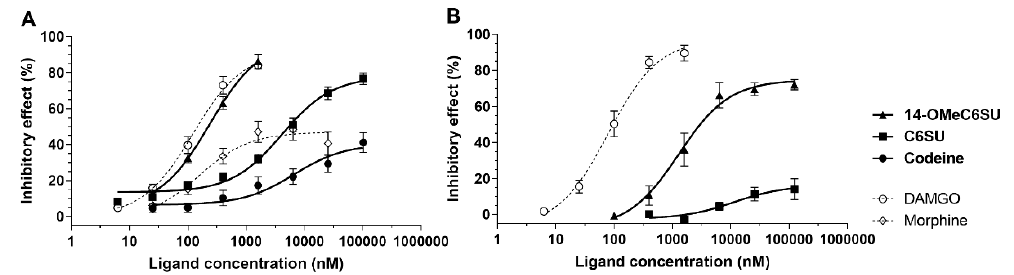
Figure 4. The inhibitory e ff ect of 14-OMeC6SU on electrically evoked contractions of MVD (panel A ) or